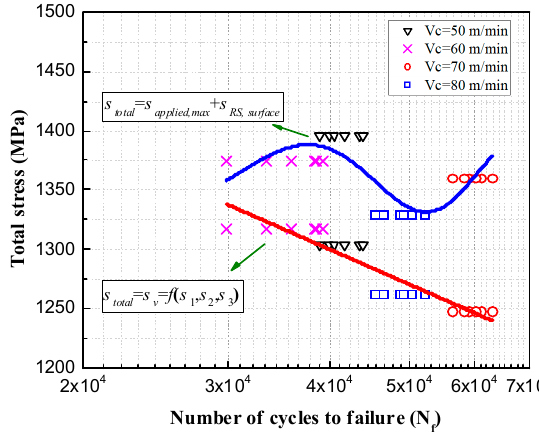
Figure 7. The relationship between the fatigue life and the total stress.